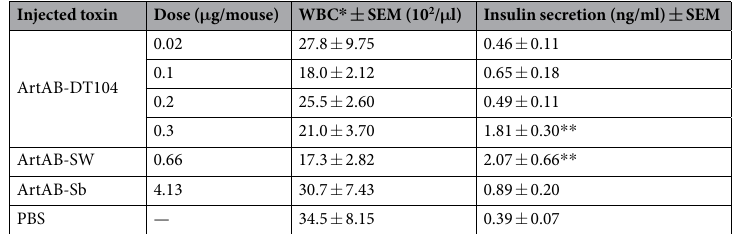
Table 2. Leukocytosis-promoting and islet-activating activity. * WBC, peripheral white blood cells. ** P < 0.05, one-way analysis of variance and Dunnett’s